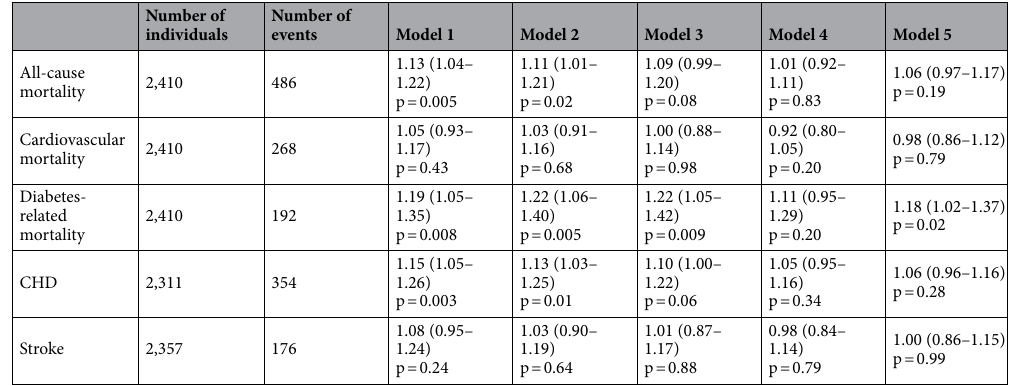
Table 3. Cox proportional hazards analysis with different levels of adjustment for cardiovascular outcomes and mortality. Hazard ratios (HRs) are presented for a 10-unit increase in H-ficolin concentration. Model 1: Unadjusted. Model 2: Diabetes duration and sex. Model 3: Model 2 + HbA 1c , systolic blood pressure, and smoking status. Model 4: Model 3 + triglycerides. Model 5: Model 4 + DKD category at